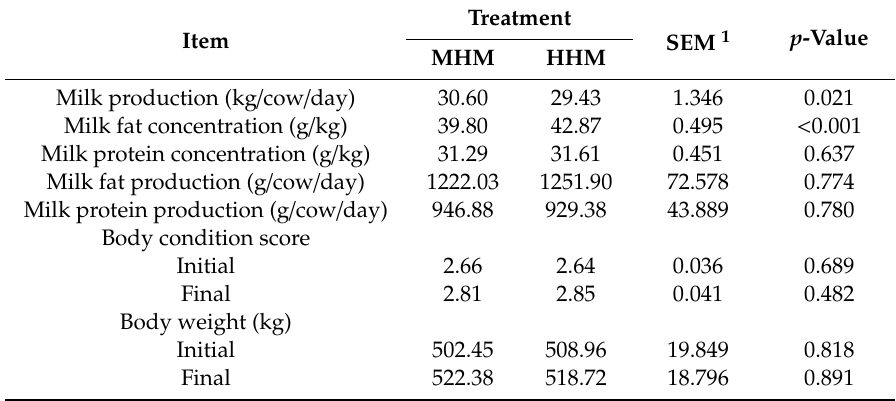
Table 2. E ff ect of medium (MHM) and high (HHM) pre-grazing herbage mass on productive performance, body condition score, and body weight of dairy